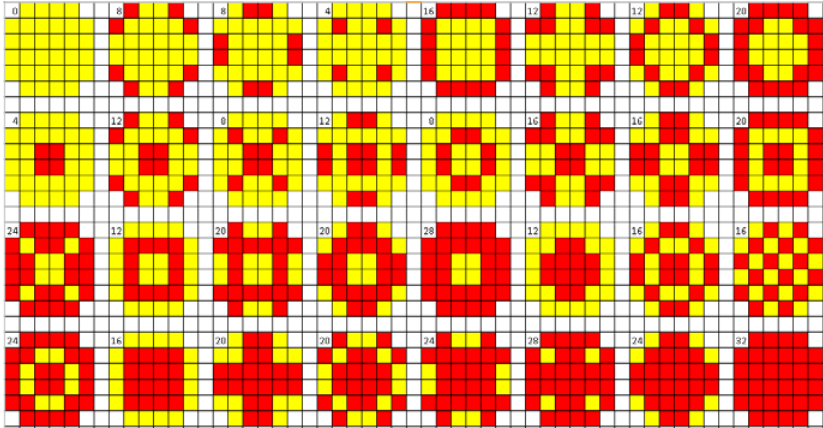
Figure 8. Determining the number of loaded absorbers (red = FA + absorber, yellow = regular